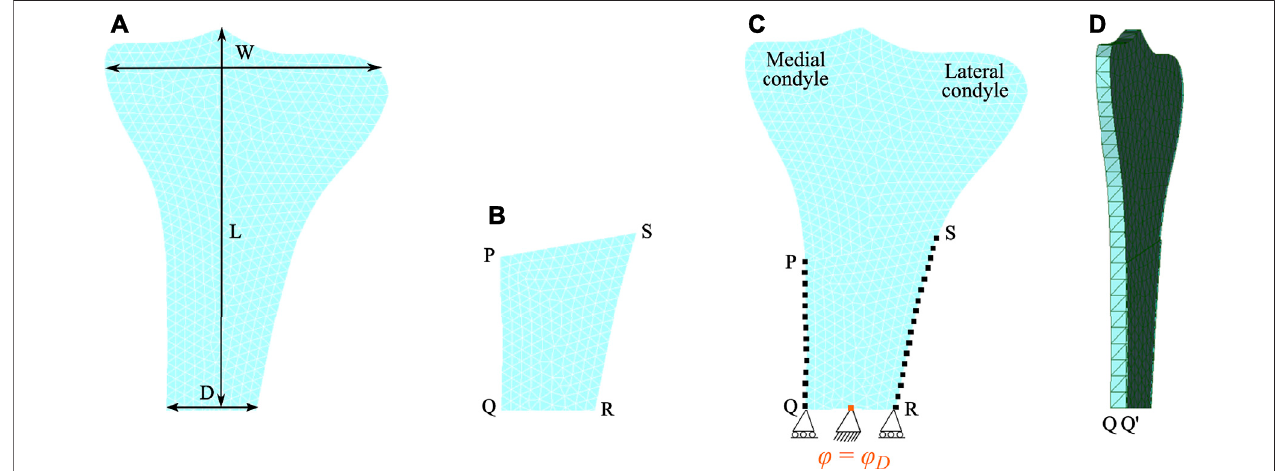
FIGURE 3 | Finite element meshed models: (A) the human proximal tibia and (B) the side-plate. (C) Both tibia and side-plate were connected to each other at medial nodes (on the edge P-Q) and lateral nodes (on the edge S-R) highlighted by black dots. Note that the electrical boundary conditions are highlighted in orange. (D) Lateral view showing the thickness of the proximal